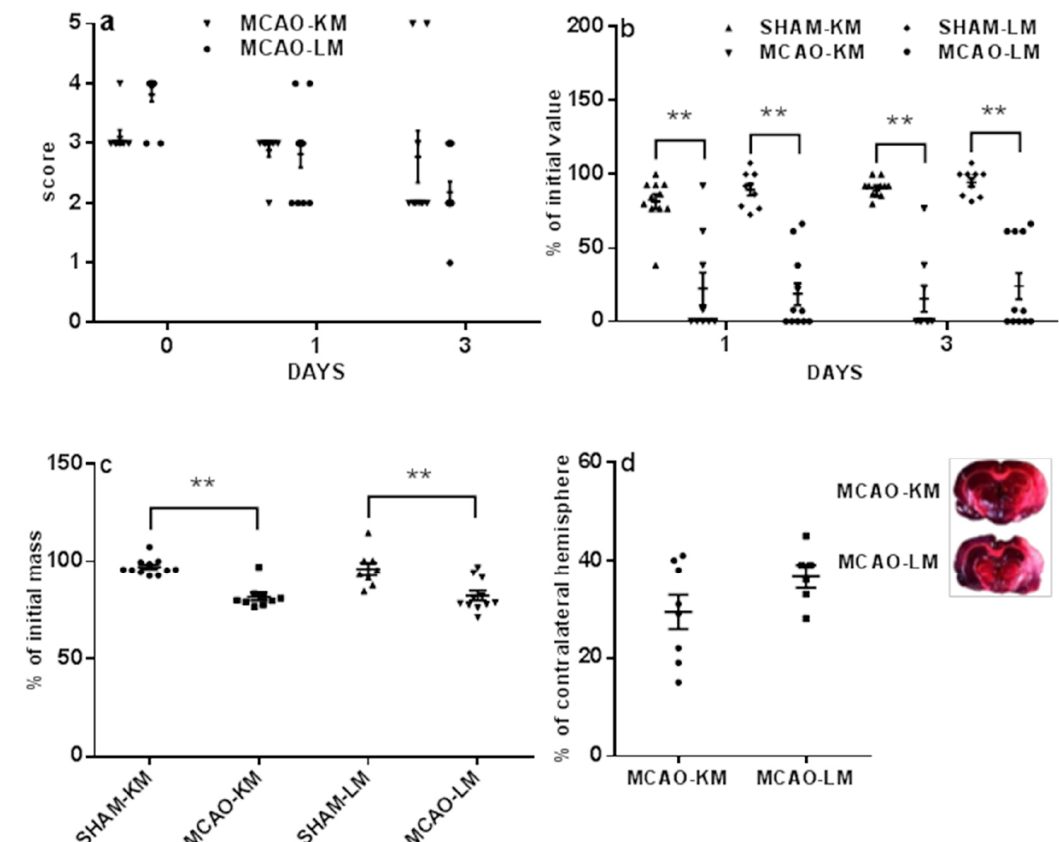
Figure 1. Neurological deficits ( a , b ), weight loss ( c ), and infarct volume ( d ) in MCAO-KM and MCAO-LM. ( a ) 5-score test after surgery (day 0), 1, and 3 days after surgery. ( b ) Tongue protrusion test 1 and 3 days after surgery; % of initial values. ( c ) Body mass 3 days after surgery; % of initial mass. ( d ) Infarct volume 3 days after surgery; % of the contralateral hemisphere; examples of TTC-stained frontal slices − 4.5 ÷ − 6.5 mm from bregma. ** p < 0.01 compared to the respective sham-operated groups.